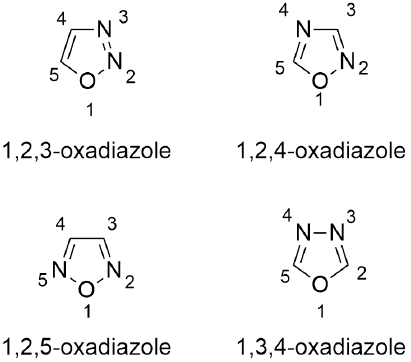
Figure 5. Structures of oxadiazoles.